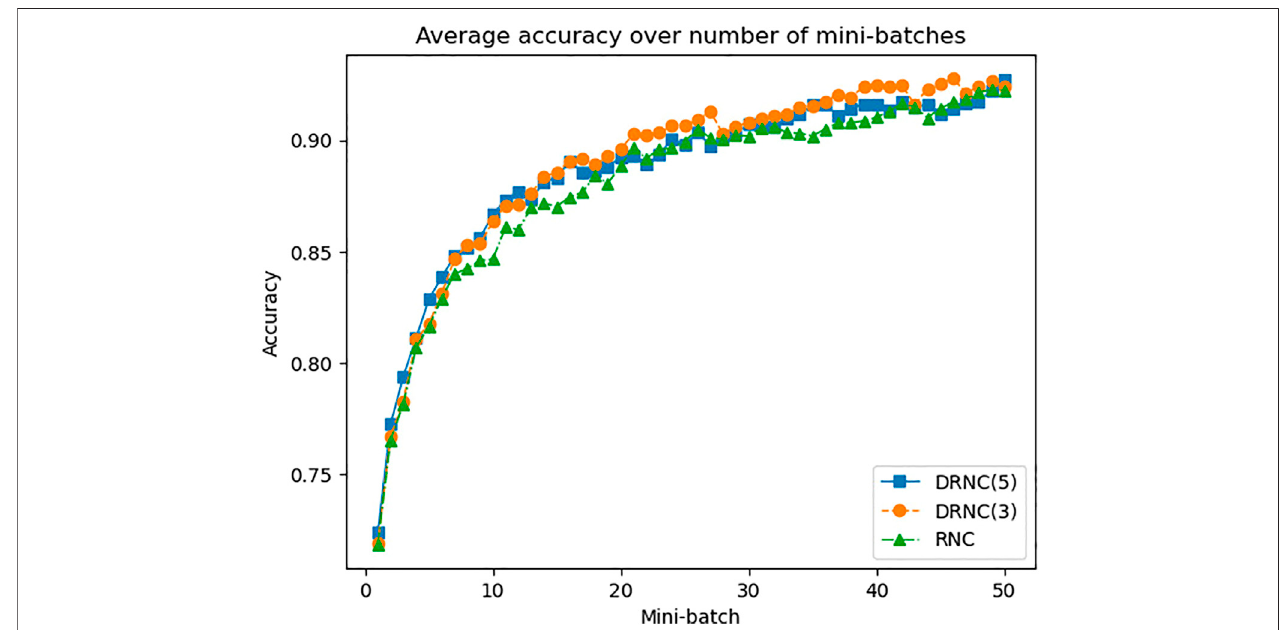
FIGURE 6 | Average accuracy of rule network with 1/3/5 layers on training dataset.